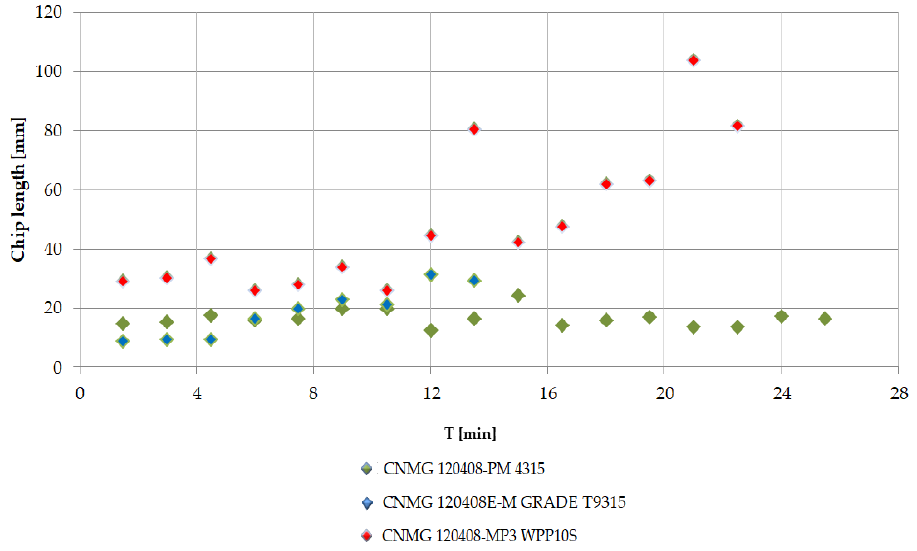
Figure 14. Chip size evolution depending on the tool turning time.